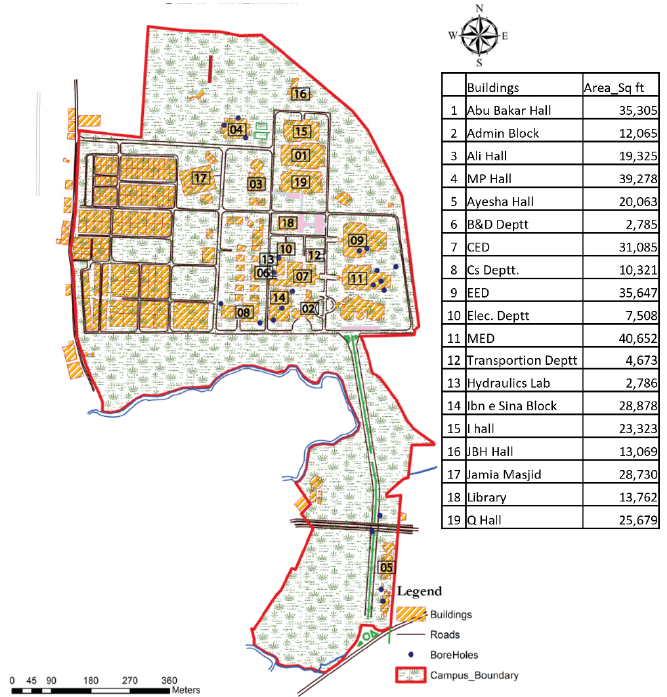
Figure 9. Demonstration of the roof tops considered and the respective area estimation for each building.